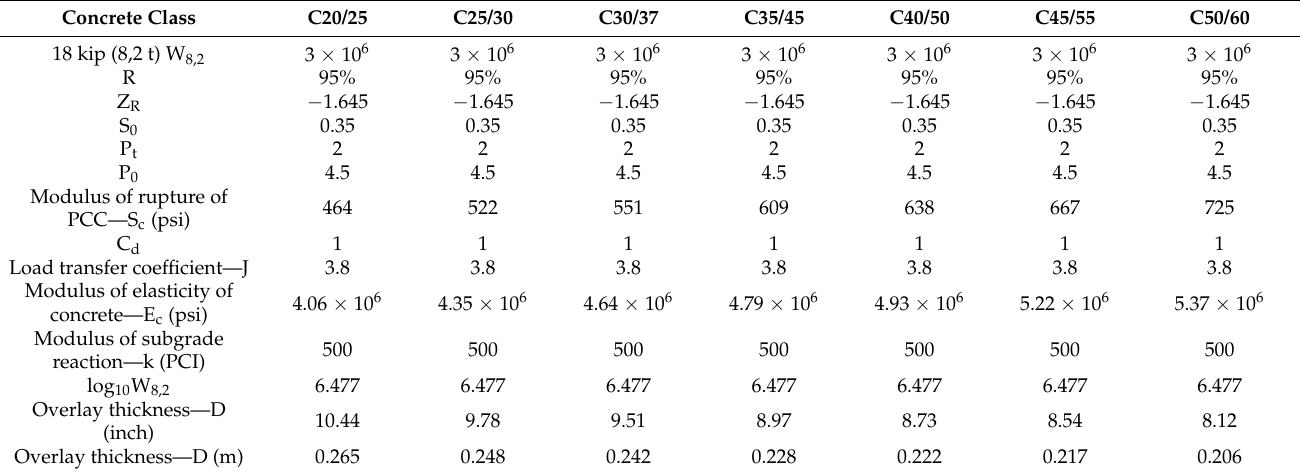
Table 2. Concrete pavement thicknesses calculated for concrete classes of C20/25 to C50/60 with the AASHTO